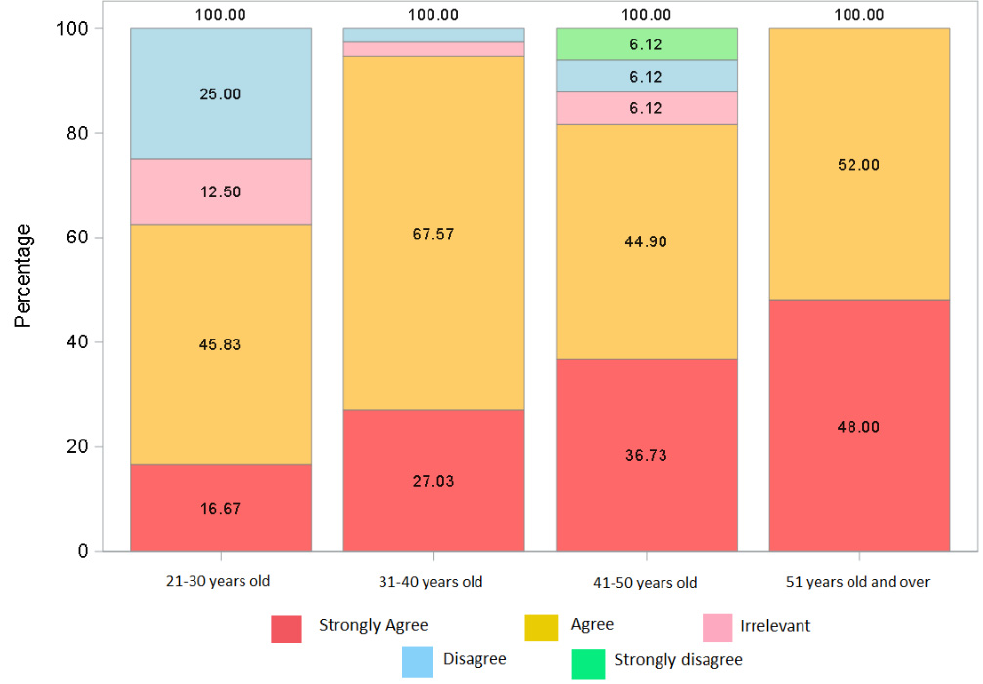
Figure 2. Training stratified by age (Q13)—(Frequency response “Strongly disagree”, “Disagree”, “Irrelevant”, “Agree”, “Strongly agree”; 20–30 years: 0, 6, 3, 11, 4; 31–40 years: 0, 1, 1, 25, 10; 41–50 years: 3, 3, 3, 22, 18; >50: 0, 0, 0, 13, 12).